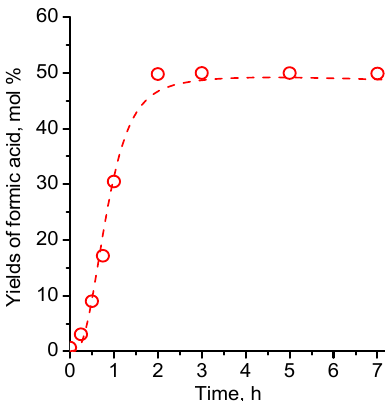
Figure 3. The experimental data (points) compared with simulated kinetic curves (dotted line) for the formation of formic acid during starch hydrolysis-oxidation. (Experimental conditions: 11.9 g/L of starch (10 g/L of dry polysaccharide), 1.25 g/L of Et 4 N-PMoV, 8/1 of starch/catalyst weight ratio (108/1 of starch/catalyst molar ratio), 60 mL of the reaction volume, 2 MPa of air, 140 °C).